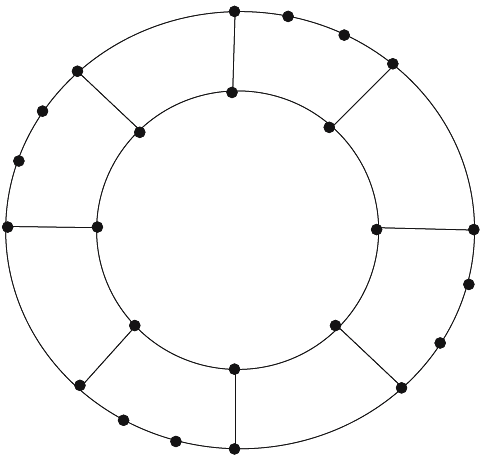
Figure 4: Molecular graph of R 4 .